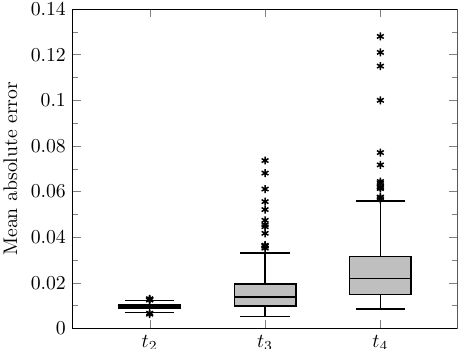
Figure 7. Boxplots of the mean absolute error distribution within the c > 0.01 contour computed voxelwise over the whole test set for times t 2 = ∆ t 1 + ∆ t 2 ∈ [ 180, 360 ] d (see Table 1), t 3 = t 2 + 90d, and t 4 = t 2 + 180d. Horizontal line: median, box: interquartile range, whiskers: ± 1.5 interquartile range, asterisks: outliers.